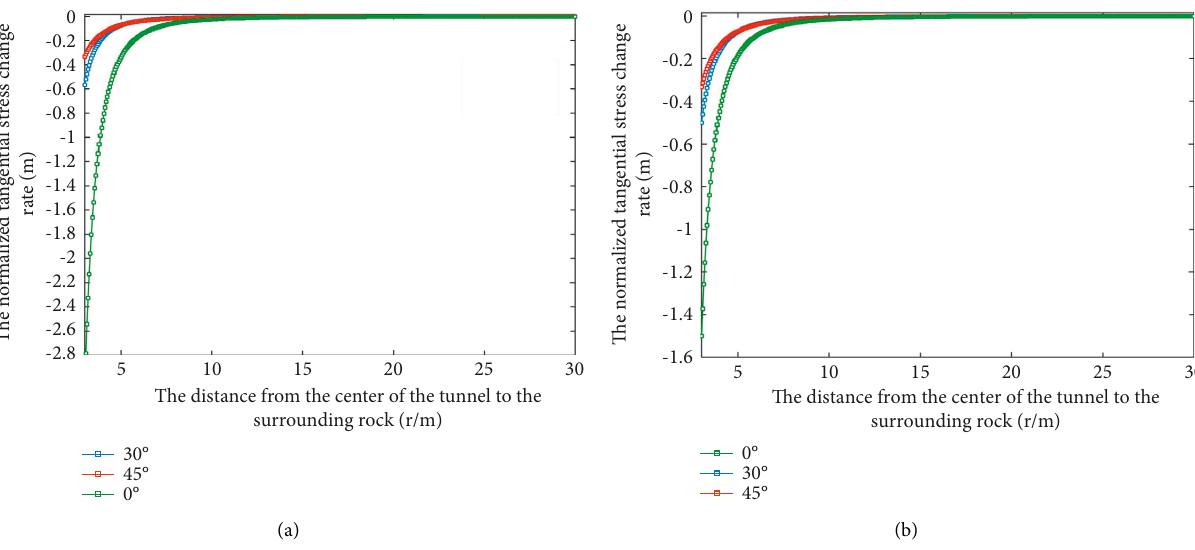
Figure 6: Change rates of tangential stress with different lateral pressure coefficients. (a) Lateral pressure coefficient λ � 0.3. (b) The lateral pressure coefficient λ � From Figure 6, the tangential stress change rates of